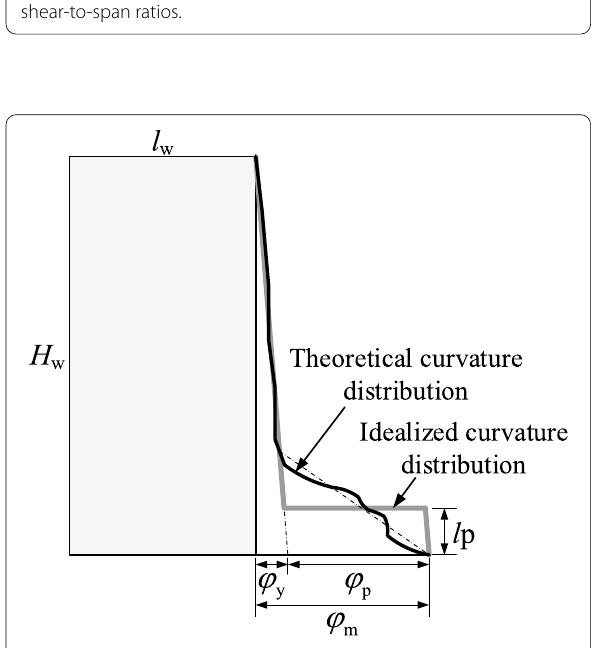
Fig. 26 Plastic hinge analysis methodology.